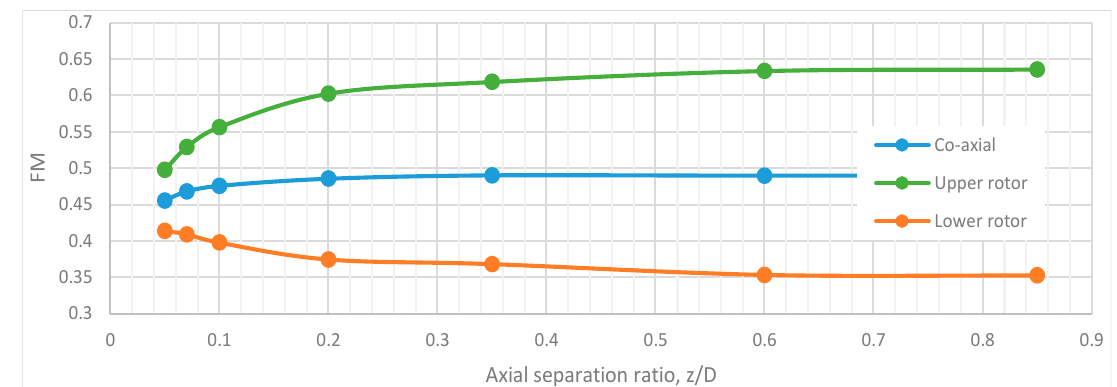
Figure 14 . Co-axial propulsion system performance at various axial separations (thrust = 8 N).